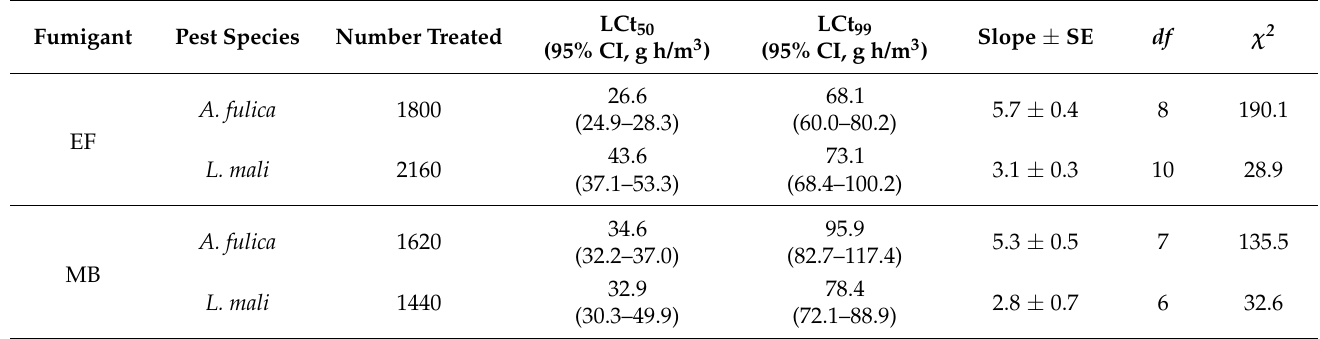
Table 1. Lethal concentration × time (LCt, g h/m 3 ) of ethyl formate (EF) and methyl bromide (MB) to juveniles of Achatina fulica and third- and fourth-instar larvae of Lycoriella mali under 4 h